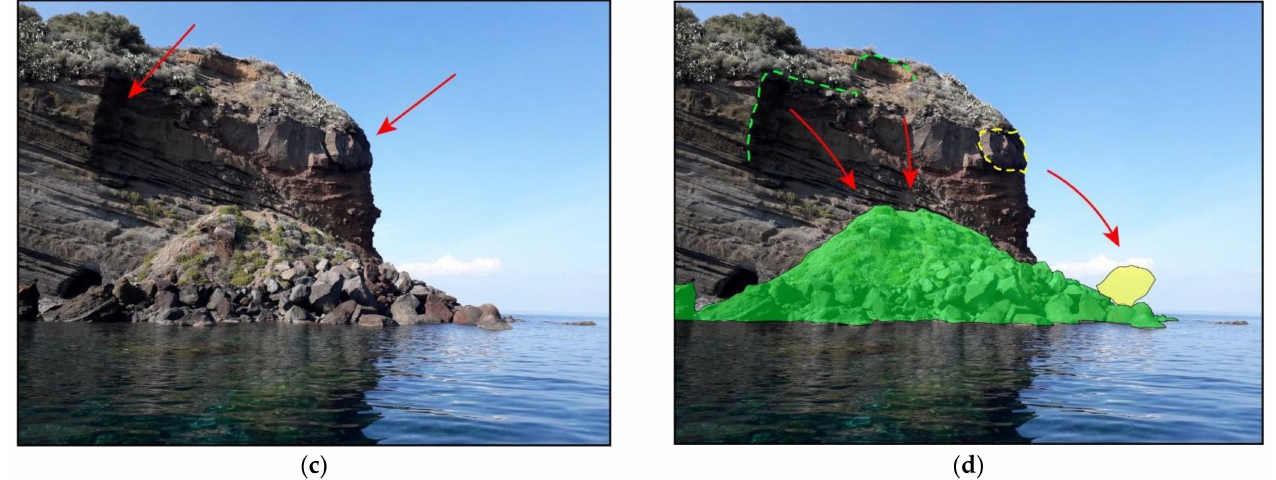
Figure 11. ( a ) The red arrow indicates the detachment cavity on the vertical cliff; ( b ) The deposits of the rockfalls and topplings coming from the cliff feed the pocket beach in front; ( c ) The lava flow referable to Vallone del Castagno Formation ( vc ) overlying the pyroclastic deposits of the Portella Formation ( po ). The left red arrow indicates the detachment area of the rock avalanche, the right one points to a fracture in the lava layer, warning of an incipient failure; ( d ) The cliff is retreating: the dashed green line indicates the crown of the rock avalanche in the vertical cliff; the yellow one the incipient detaching block, probably falling onto rock avalanche deposits. Detrital blocks maximum dimensions are about 70 m 3 , assessed with the dense point